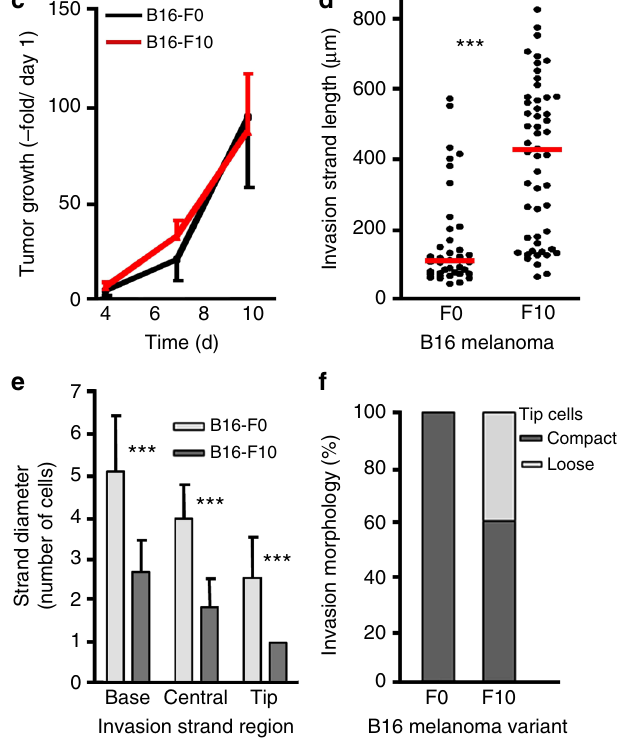
Fig. 3 Structure of the linear invasion strands in vivo. a Live B16-F0 (non- metastatic) and B16-F10 (metastatic) tumors in mouse skin imaged with epi fl uorescence microscopy (cell nuclei marked with Histone-2B/mCherry, green). Images are representative of least six tumors from at least three independent mice per group. Insets show fi nger-like invasion strands moving away from the main tumor mass. Scale bar is 100 μ m. b Enlarged images corresponding to the tips of the invasion strands. Few (~2 – 4) B16- F10 cells, so-called tip cells, detached from the invasion strands and exhibited trajectories that over limited observation time appeared ballistic (see also Fig. 4b, Zone 5). These tip cells were observed only in the very outer zone 5 which was not included in Lévy walk analysis because of small tumor growth (quanti fi cation based on tumor volume and expressed as an increase over volume measured on day 1; time, days) and ( d ) invasion strand length on day 6. Invasion strands were statistically longer in horizontal lines). Error bars in c are standard deviations based on ≥ 30 invasion strands from at least six tumors of three individual mice. e The widths of invasion strands near the base (i.e., beginning of strand at tumor ’ s edge), center between base and tip, and the tip region (recorded on day